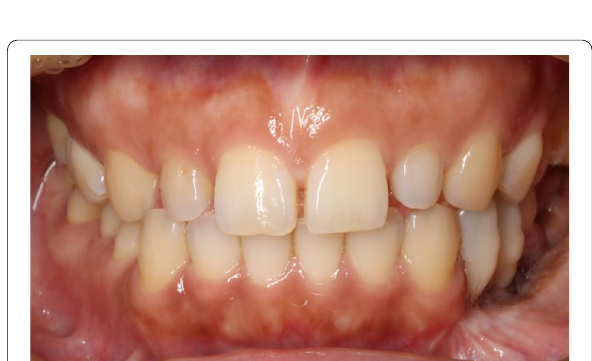
Fig. 9 Intraoral view after prosthetic